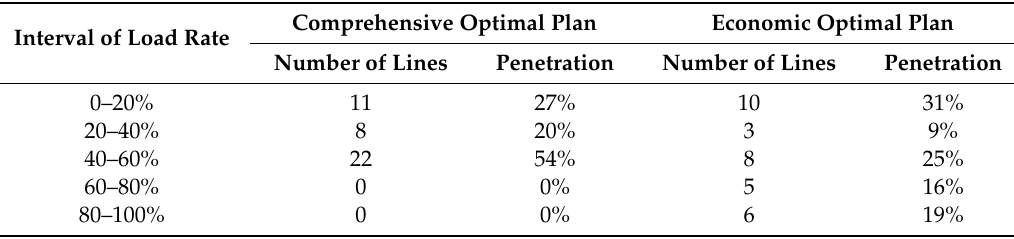
Table 4. Distribution of expected line load